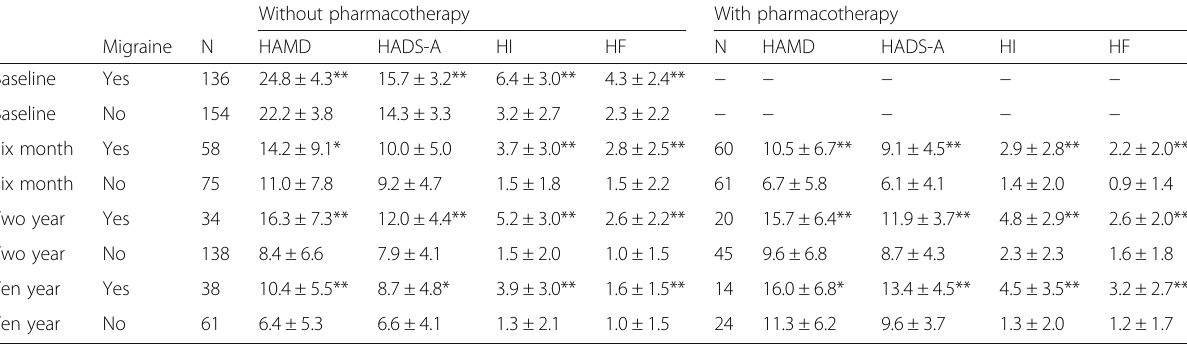
Table 3 The difference of psychometric scores and headache indices at four time points between patients with and without migraine a Without pharmacotherapy With pharmacotherapy Migraine